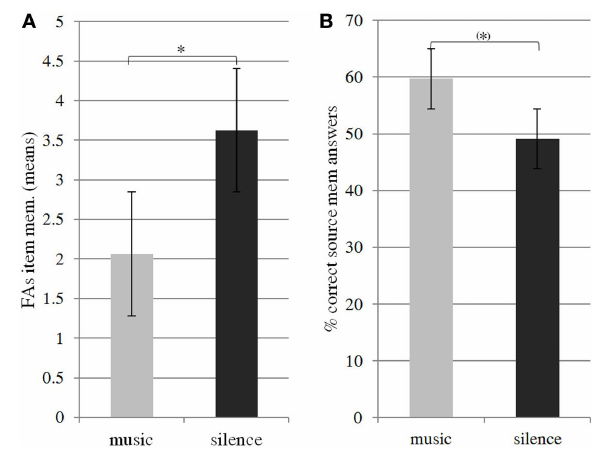
FIGURE 2 | Item-memory false alarm scores (A) and source memory correct answer scores (B) . Paired t -tests showed fewer errors in item-memory performance and overall better source memory performance in the music condition than in the silence condition. One-sample t -tests revealed that music source memory scores were significantly above chance level, while silence source scores were not. * and (*) indicate, respectively, significant ( p < 0.05) and marginally significant (0.05 < p < 0.07) difference in